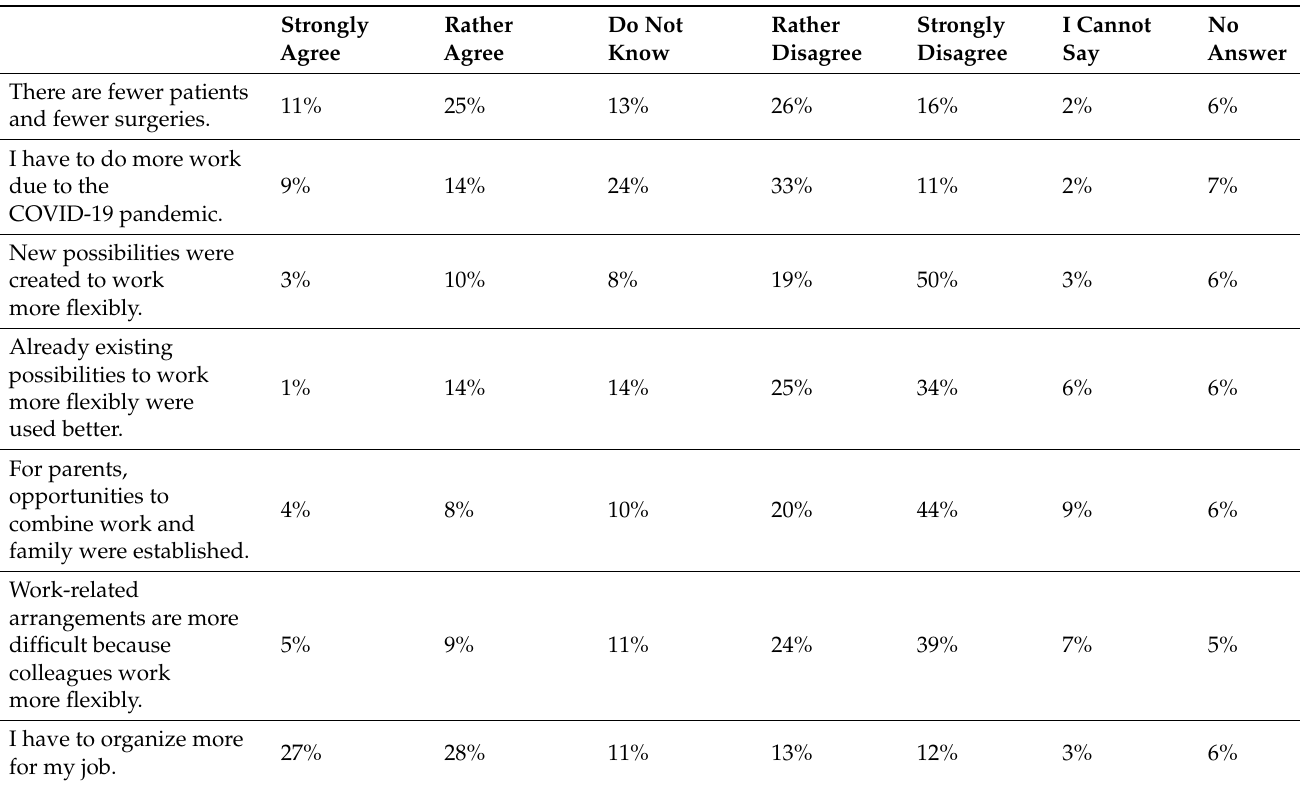
Table 2. Effects of the pandemic on working